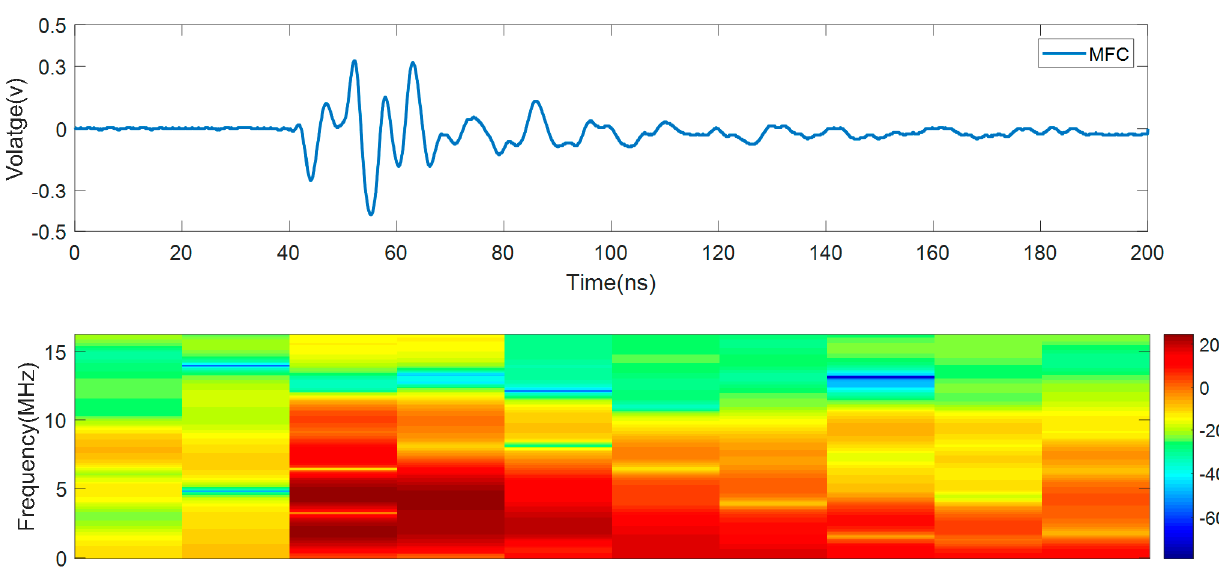
Figure 11. Spectrogram of the PD acoustic signal captured by the PZT sensor.